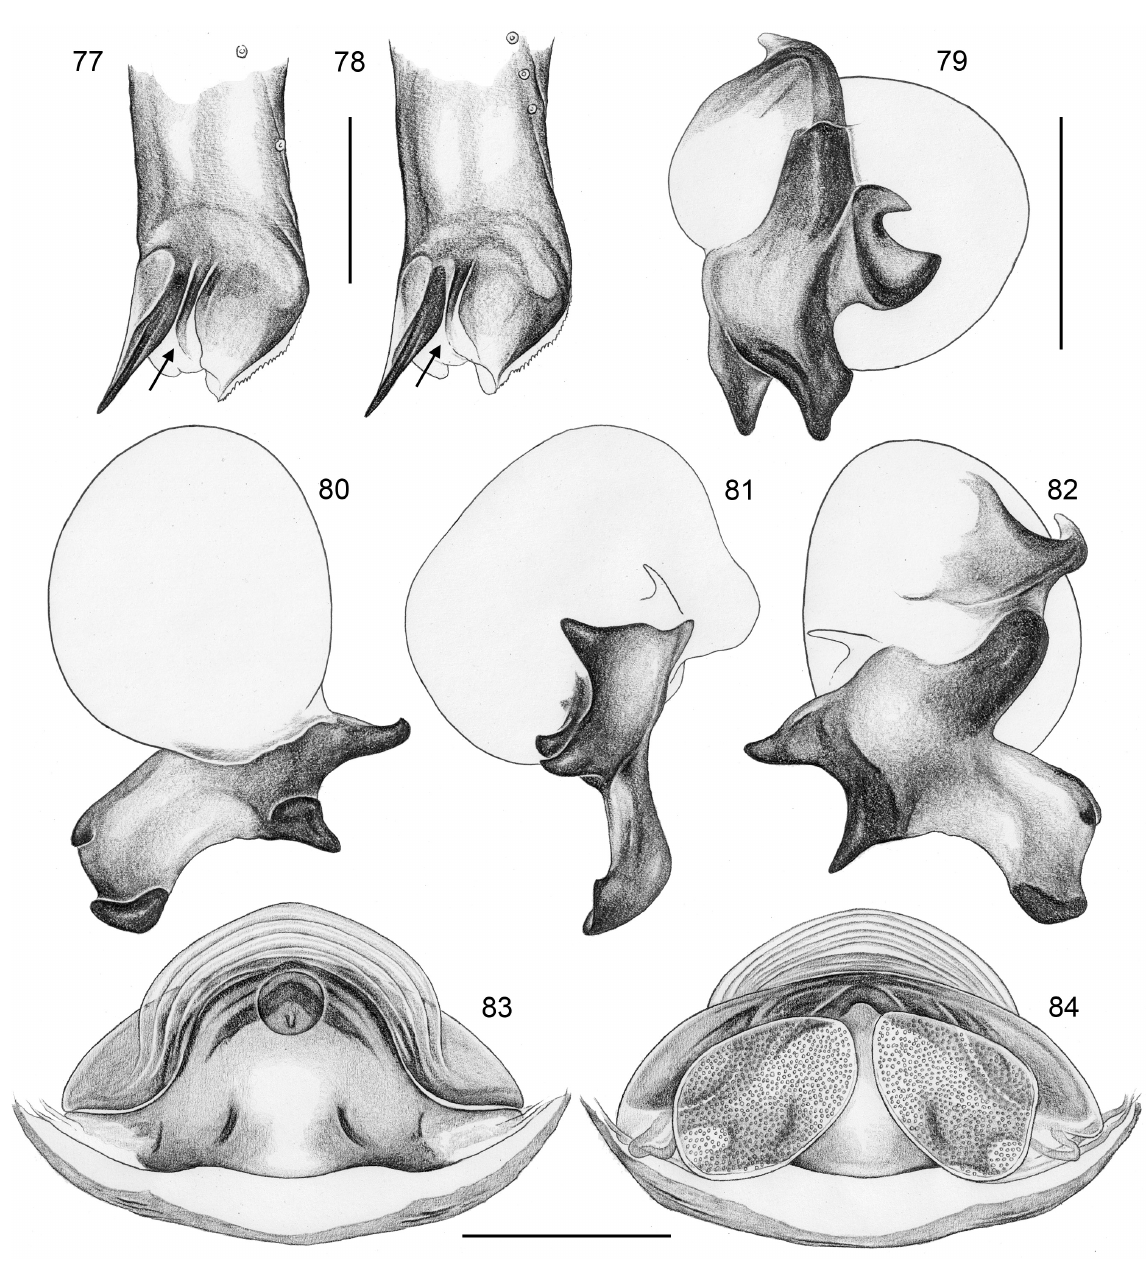
Figs 77–84. Stygopholcus montenegrinus Kratochvíl, 1940. 77–78 . Males from Studenačka pećina, Montenegro (ZFMK (Ar 22201)) and from Zeze Cave, Albania (CMK), tips of left procursi, prolateral (slightly ventral) views; arrows point at distinctive prolateral sclerites. 79–82 . Male from Studenačka pećina (ZFMK (Ar 22201)), left genital bulb, retrolateral, ventral, prolateral-distal, and dorso-distal views. 83–84 . Female from Studenačka pećina (ZFMK (Ar 22201)), cleared female genitalia, ventral and dorsal views. Scale bars: 0.5